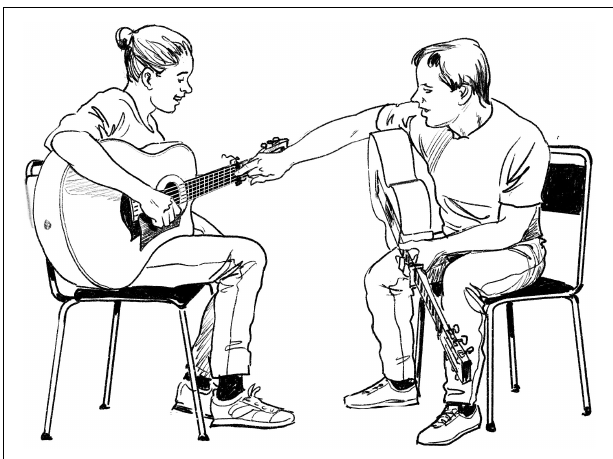
FIGURE 2 | The teacher instructing the student.